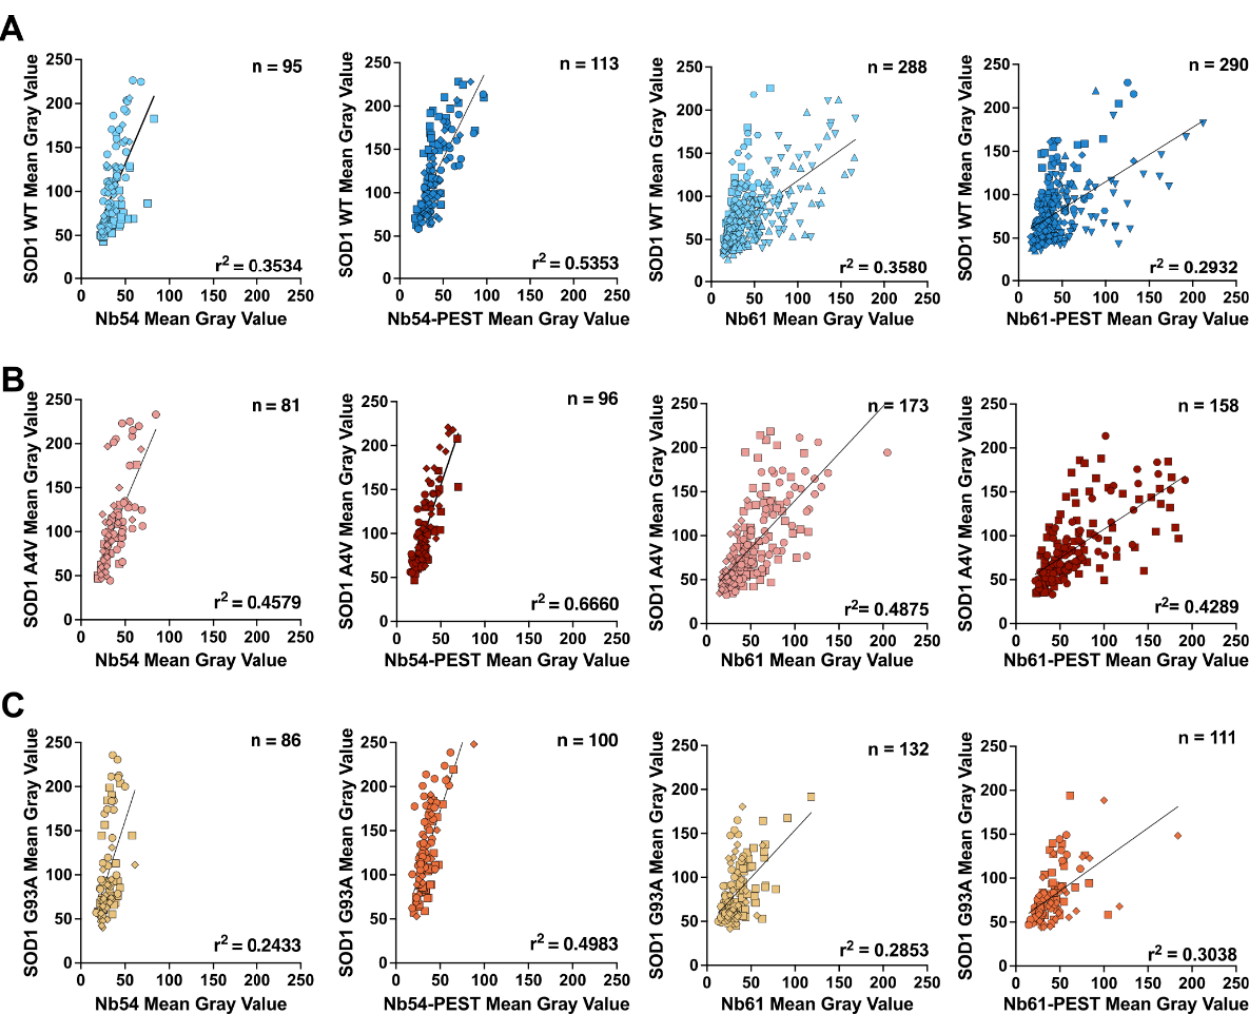
Figure 3. Exogenous expression levels of SOD1-myc and nanobody proteins are positively correlated in cellulo. Linear-regression analyses of SOD1 and nanobody signal intensity. For all conditions there is a moderate positive correlation, with SOD1 and Nb54-PEST co-transfections demonstrating the strongest correlations. ( A ) HEK293T cells co-transfected with SOD1 WT and Nb54, Nb54-PEST, Nb61, or Nb61-PEST. ( B ) HEK293T cells co-transfected with SOD1 A4V and Nb54, Nb54-PEST, Nb61, or Nb61-PEST. ( C ) HEK293T cells co-transfected with SOD1 G93A and Nb54, Nb54-PEST, Nb61, or Nb61-PEST. For ( A – C ): Data are pooled from three biological replicates with the exception of SOD1 WT co-transfected with Nb61 and Nb61-PEST, which are pooled from six biological replicates. Each point represents one cell; each symbol denotes a specific biological replicate. The r 2 values reflect the fit of experimental data to the depicted regression line. Increasing r 2 values indicate that the SOD1 and Nb signal intensities are positively correlated.